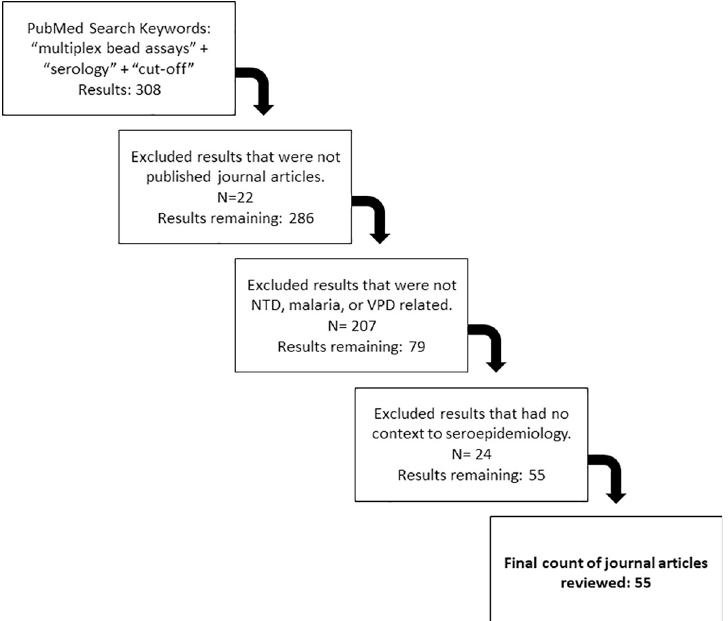
Fig 1. Flowchart of article selection for inclusion in literature review. The PubMed search identified 308 articles with 253 being excluded because they did not meet the inclusion criteria. After review, 55 articles were retained for